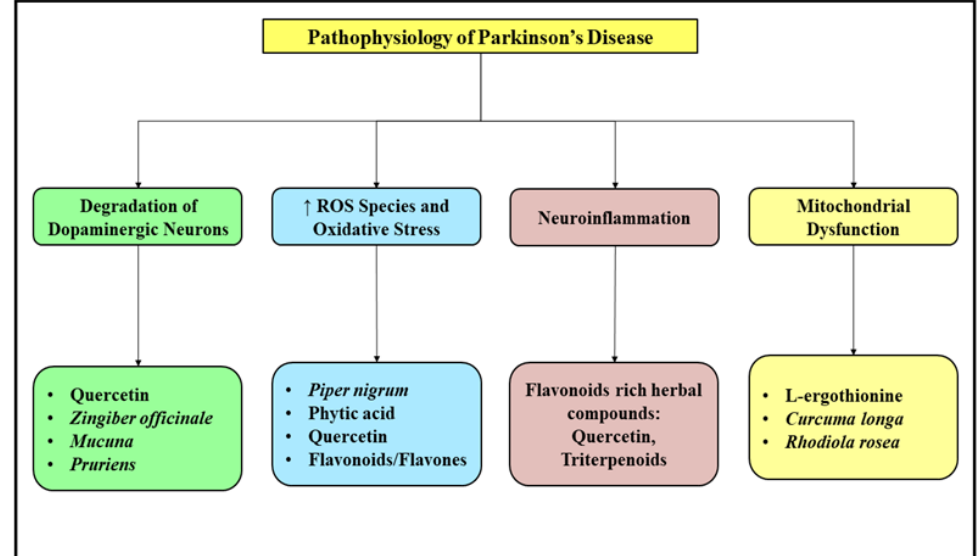
Figure 3. Pathological factors responsible for initiation and prolongation of Parkinson’s disease along with a list of herbal plants and bioactive natural origin molecules exhibiting anti-Parkinson activity. ROS: Reactive oxygen species.